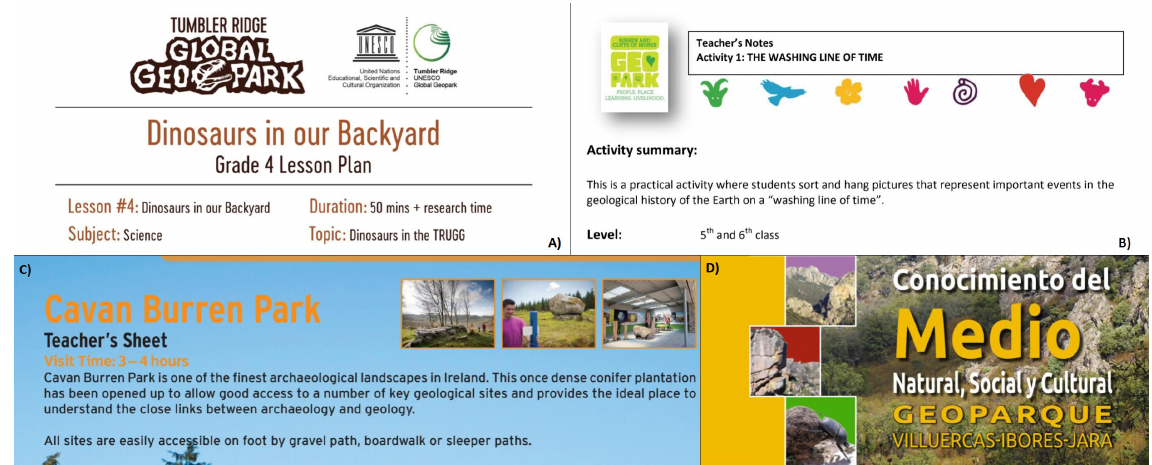
Figure 5. Examples of educational materials produced in UNESCO Global Geoparks. A) Lesson plan of the Tumbler Ridge Geopark (https://www.tumblerridgegeopark.ca/); B) Lesson plan of the Burren & Cliffs of Moher Geopark (https://www. burrengeopark.ie/); C) Field guide designed for teachers of the Marble Arch Caves Geopark (https://www.marblearchcaves- geopark.com/); D) Textbook of the Villuercas-Ibores-Jara Geopark